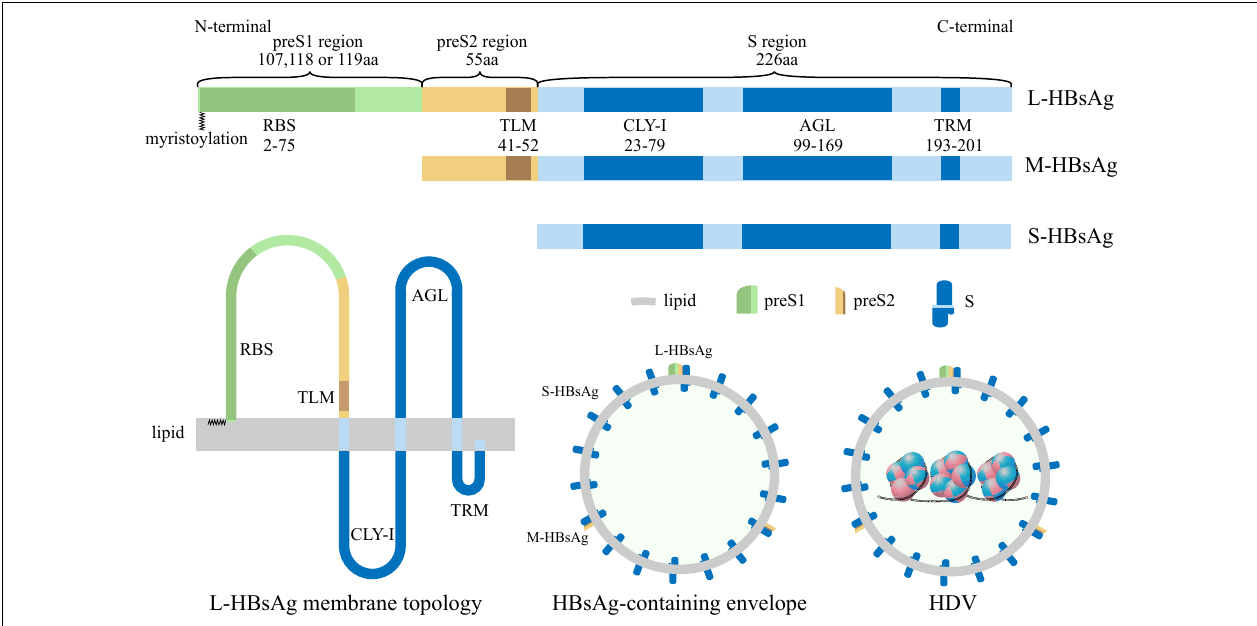
FIGURE 3 | Structure of HBsAg, HBsAg-containing envelope and HDV. S-HBsAg contains S region (blue box), M-HBsAg contains preS2 (yellow box) and S region, and L-HBsAg contains preS1 (green box), preS2 and S region, and the N-terminal of L-HBsAg is myristoylated (zigzag line). Receptor-binding site (RBS) located at preS1 region; Translocation motif (TLM) located at preS2 region; Cytosolic loop I (CYL-I), antigenic loop (AGL), and try-rich motif (TRM) located at S region. The HBsAg-containing envelope of HDV is a host-derived outer surface lipid coat containing three forms of HBV surface